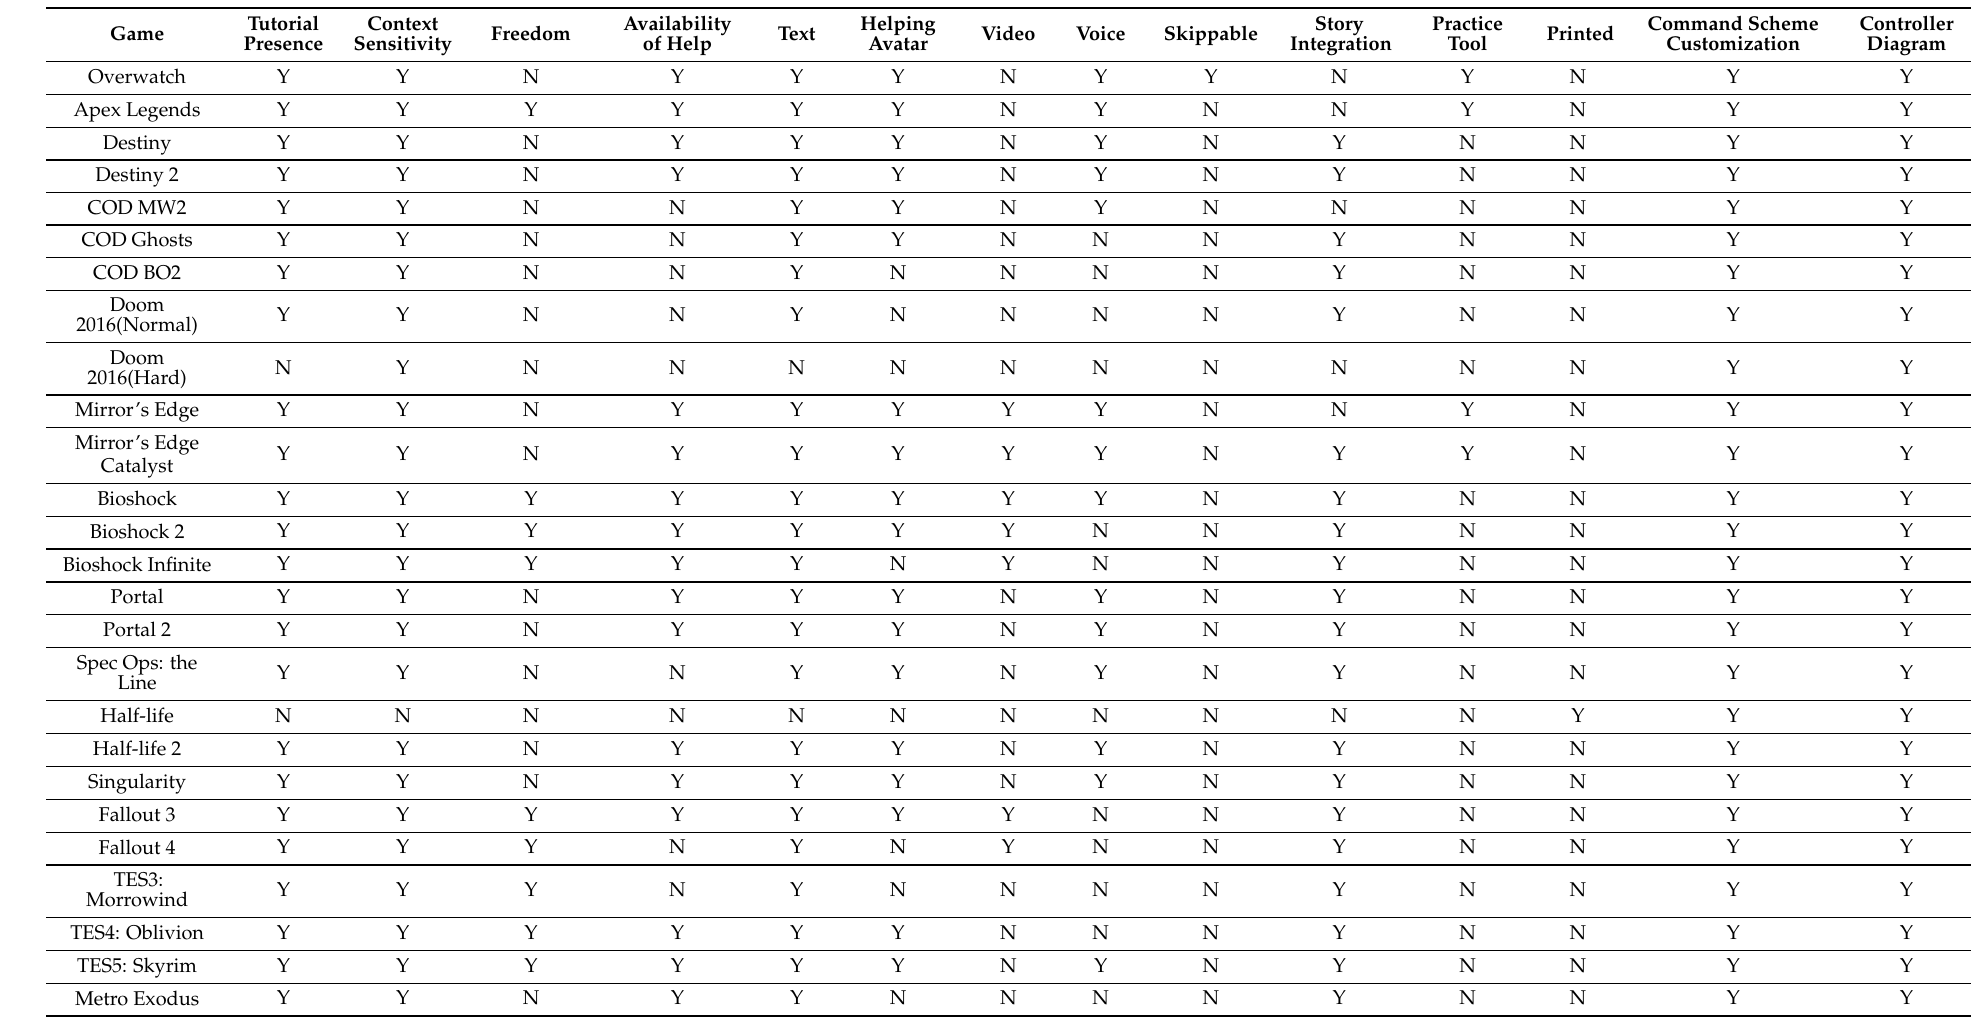
Table 1. Data gathered from 32 tutorials of FPSs available in the